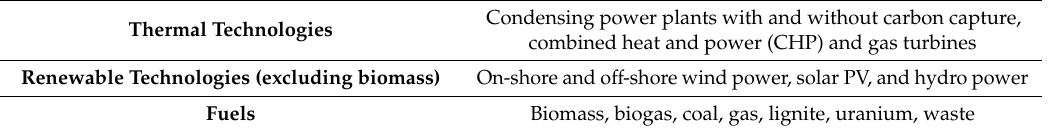
Figure 1. Schematic of the modelling package applied in this work. Table 1. Technologies and fuels included in the modelling